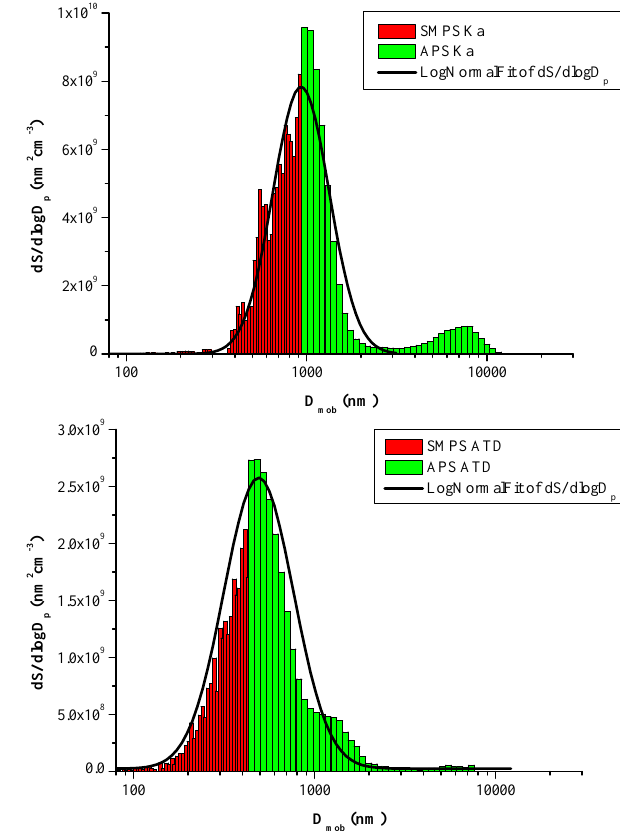
Fig. 2. Representative number size distributions for Ka (top) and ATD (bottom) of suspended dust particles in aerosol tank recorded with an SMPS and APS simultaneously. We note that IN counters sampled through a 1µm impactor necessitating the use of particle number distributions of less than 1.14µm aerodynamic diameter for ice-active fraction calculations.